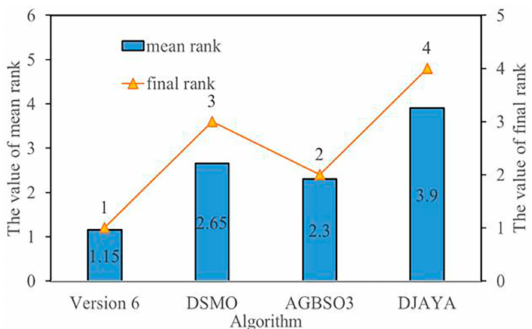
Figure 5. The ranks of the four participating